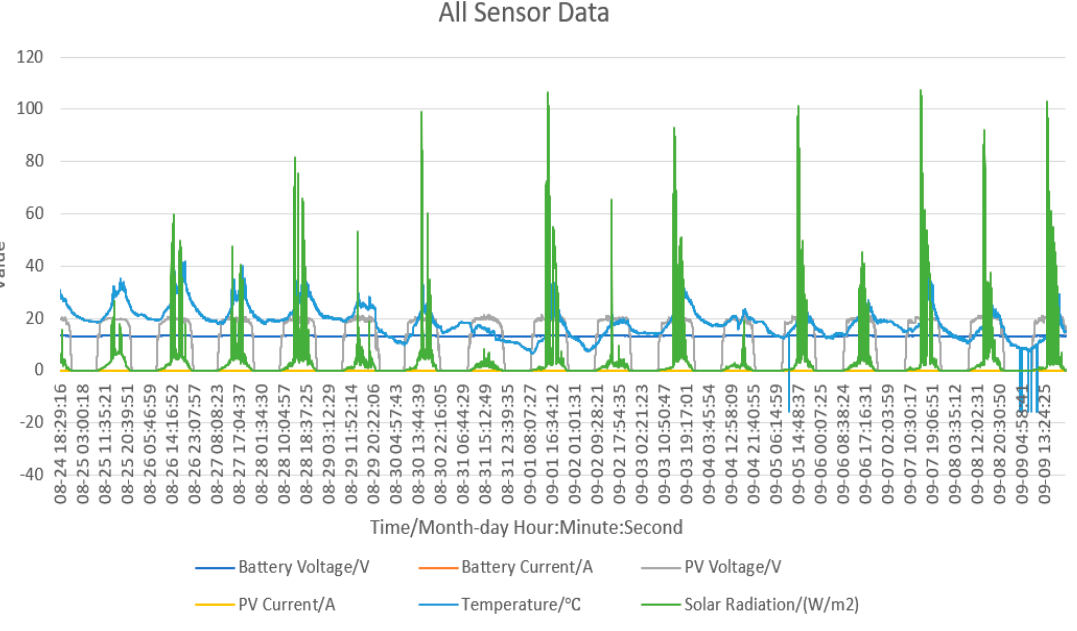
Figure 21. All sensor data.